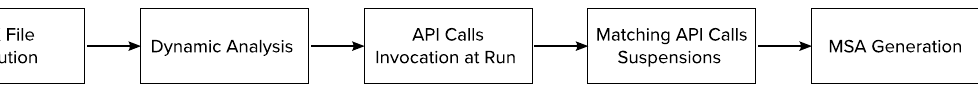
Figure 4. Process pipeline of training PHMM to produce MSA.